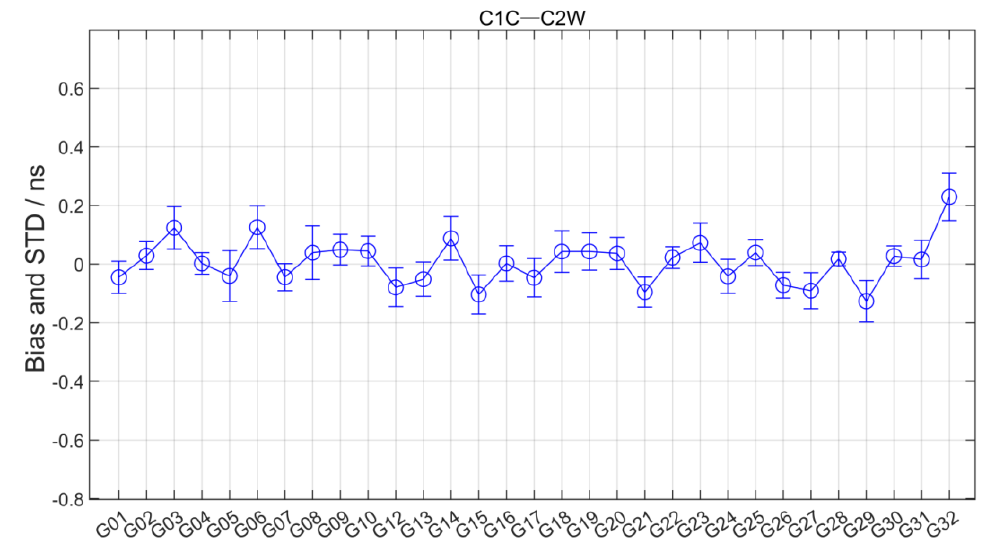
Figure 20. Comparison results between DCB and CAS products of GPS satellite.